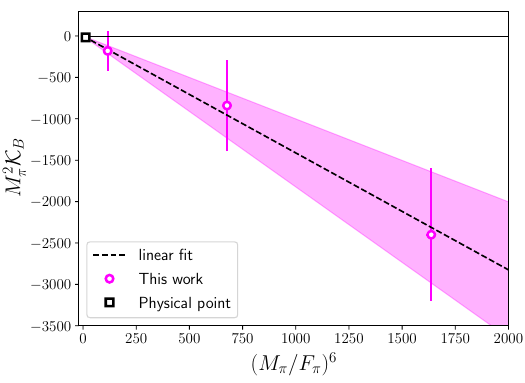
Figure 10. Chiral scaling of K B for pions as a function of ( M π /F π ) 6 , including a linear fit. Notation as in figure